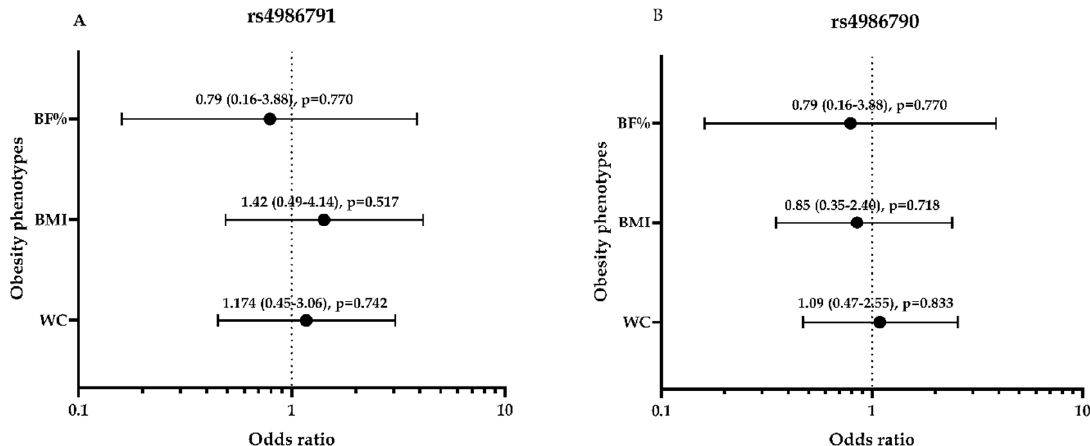
Figure 4. The genetic variants rs4986791 (Thr399Ile) and rs4986790 (Asp299Gly) polymorphisms-related odds ratios and 95% CI with obesity phenotypes. Data are expressed as odds ratio (odds ratio of 95% lower and upper confidence interval (CI) with their p -values) for the independent variables of obesity phenotypes: %BF, BMI and WC with rs4986791 ( A ) and rs4986790 ( B ) in their dominant model in obese subjects versus non-obese as controls. Logistic regression analysis was used for data analysis. Two-tailed p -value is significant at ≤ 0.05. BMI, Body Mass Index; WC, Waist Circumference; BF%, Body Fat